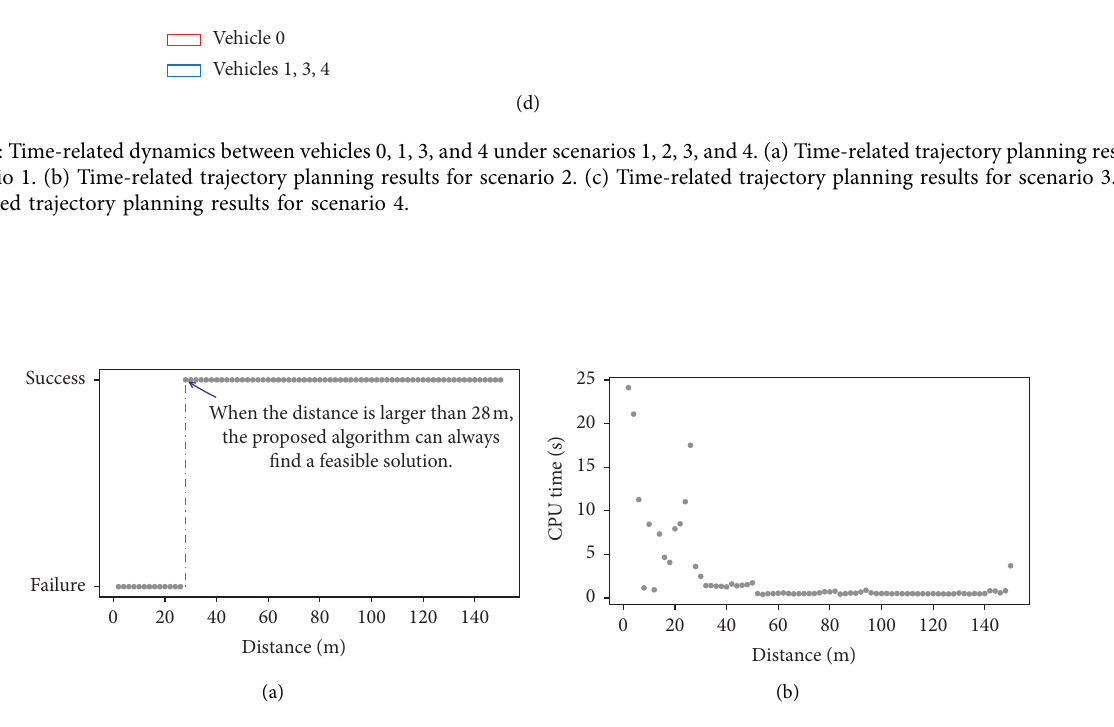
Figure 11: Effect of the distance between vehicle 0 and vehicle 1. (a) Effect of the distance on the feasibility of the algorithm. (b) Effect of the distance on the computational load of the algorithm.